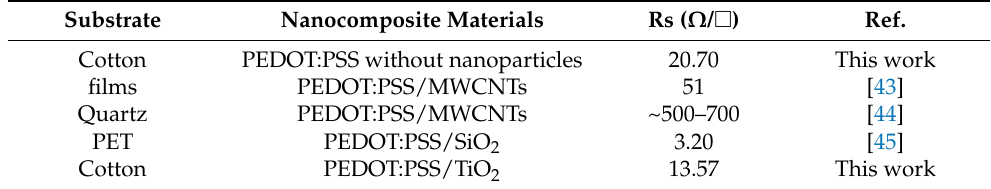
Table 2. Comparison of sheet resistance values between our work and other reports in the literature.